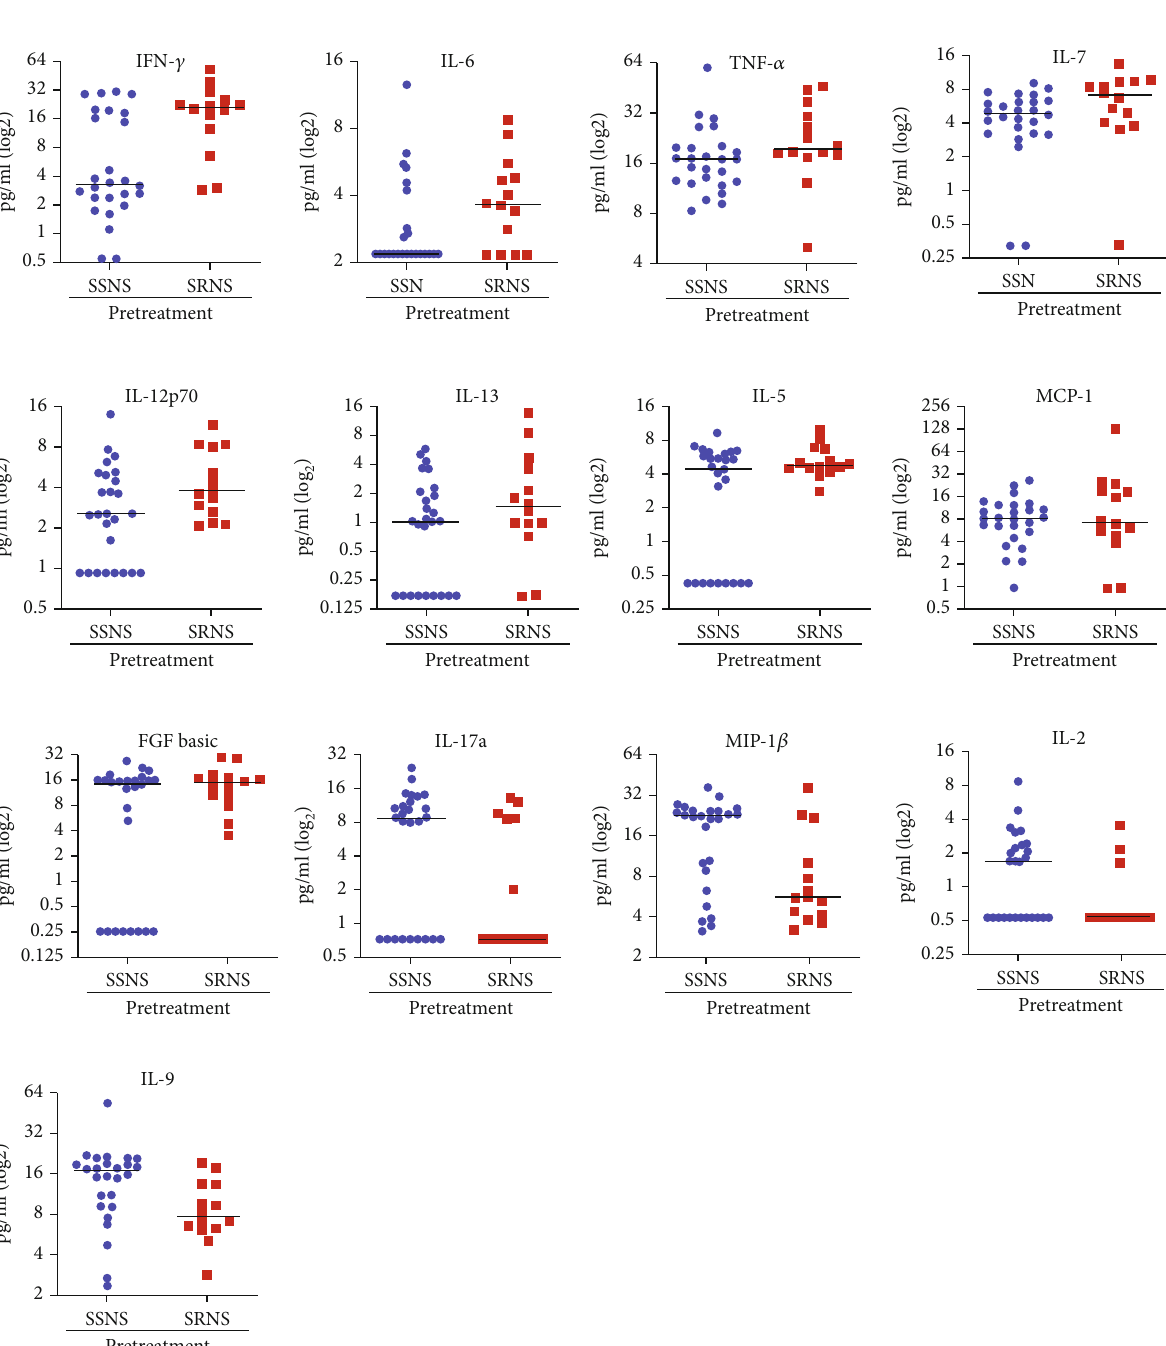
Figure 1: Cytokines can identify the SRNS cases before therapy. Di ff erent levels of 13 plasma cytokines were observed between SSNS versus SRNS before therapy, three of which (MCP-1, IL-9, and L-7) had values to discriminate SRNS from SSNS prior to glucocorticoid therapy with ROC value = 0 : 84 , 0.64 sensitivity, and 0.84 speci fi city. FGF: fi broblast growth factor; MCP-1: monocyte chemoattractant protein-1; MIP-1 β : macrophage in fl ammatory protein-1 β ; SSNS: steroid-sensitive nephrotic syndrome; SRNS: steroid-resistant nephrotic syndrome; TNF: tumor necrosis factor; ROC: receiver operating characteristic. Adapted from Ref. [28] with permission. The reference [28] article is available under the Creative Commons CC-BY-NC-ND